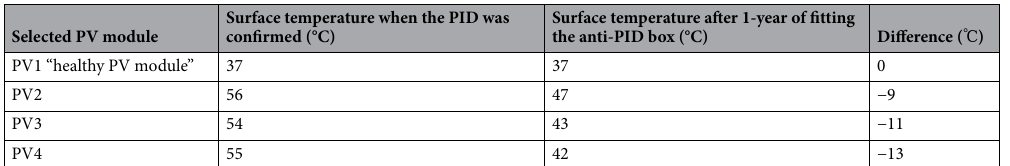
Table 3. Thermal difference between the selected PV modules.